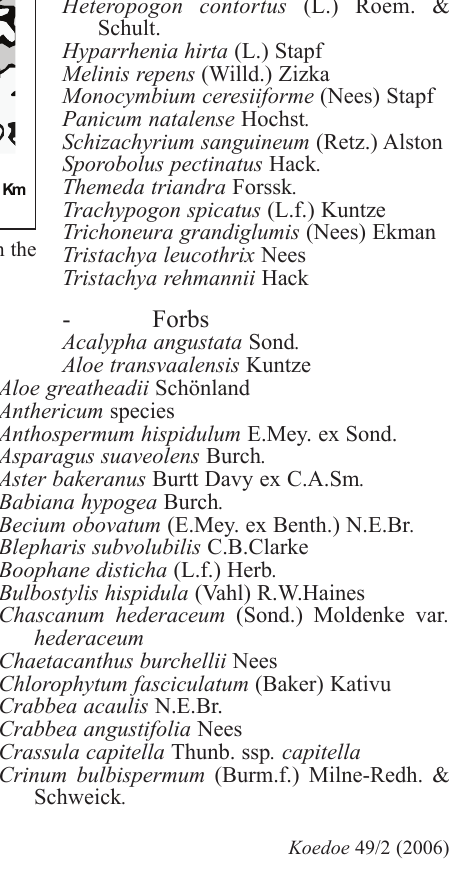
Gymnosporia buxifolia L.